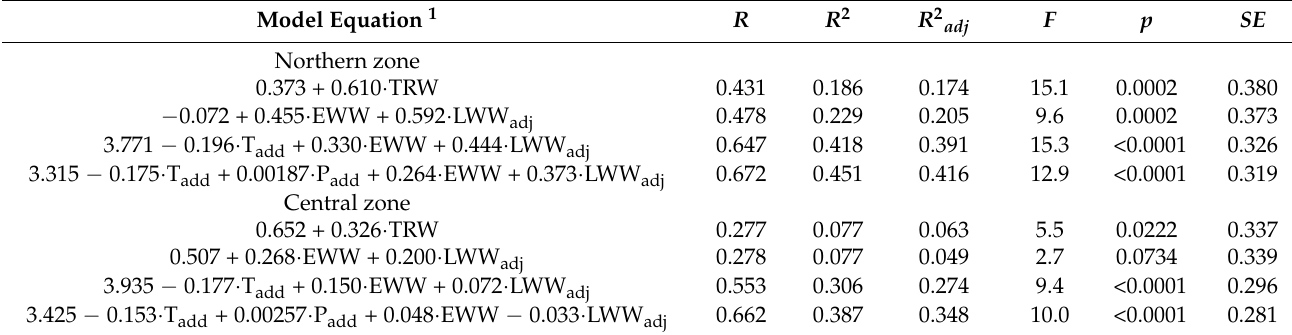
Table 2. Linear regression models of crops yield zonal chronologies (Northern and Central zones) based on larch tree-ring standardized regional chronologies and climatic